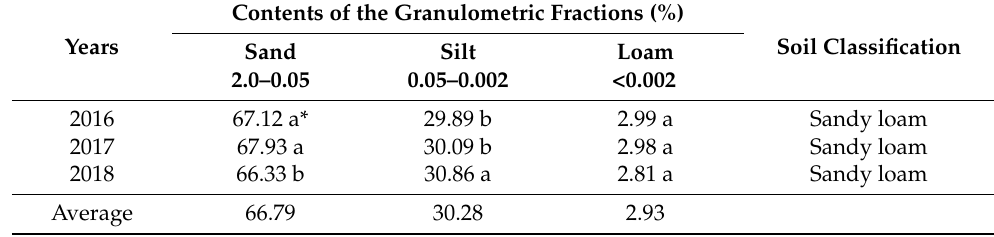
Table 1. Soil granulometric composition (2016–2018).